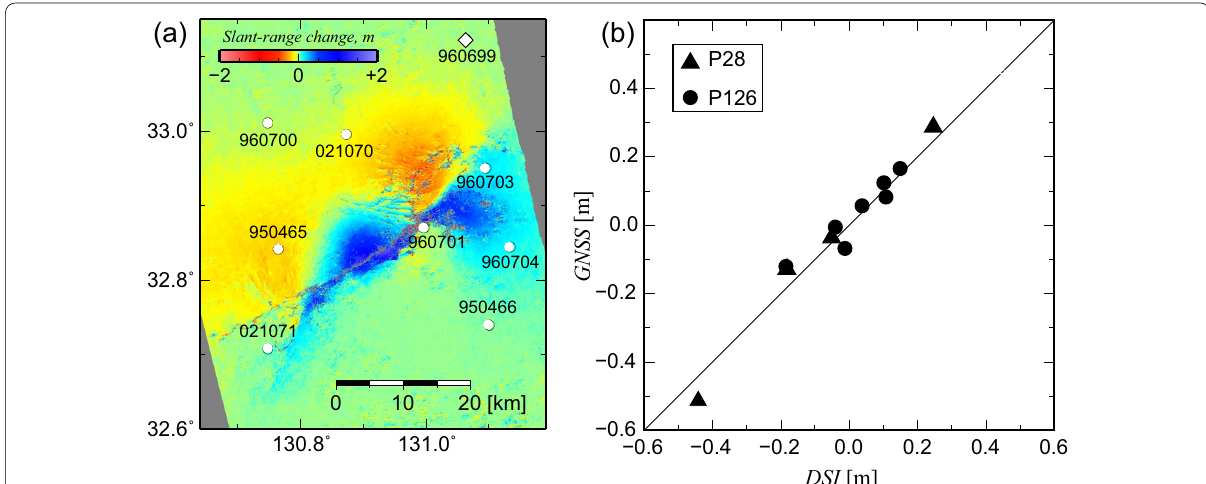
Fig. 4 a Distribution of the GEONET stations used in the comparison of slant-range changes. The background depicts the slant-range change maps for Path 126 using the difference of split-band interferograms (DSI) analysis. The open diamond indicates GEONET station “960699,” the reference point of crustal deformation. b Comparison of slant-range changes obtained from the DSI analysis and GEONET. Triangles and circles indicate the slant-range changes for Paths 28 and 126,